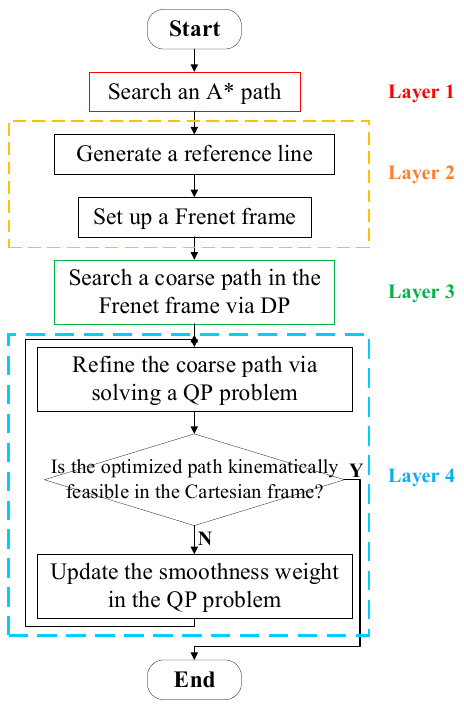
Figure 2. Overall framework of occlusion-aware path planning method.